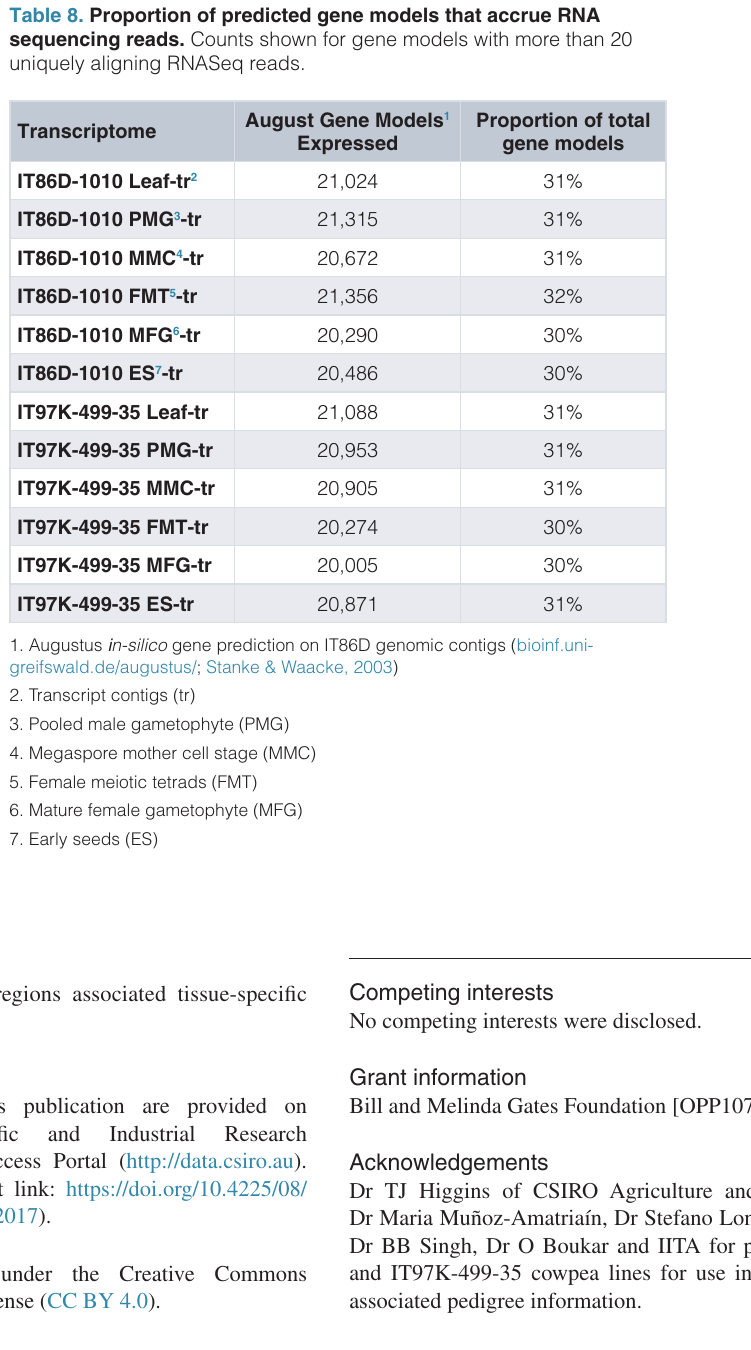
Supplementary Figure 1: Pedigree maps of IT97K-499-35 and IT86D-1010. Click here to access